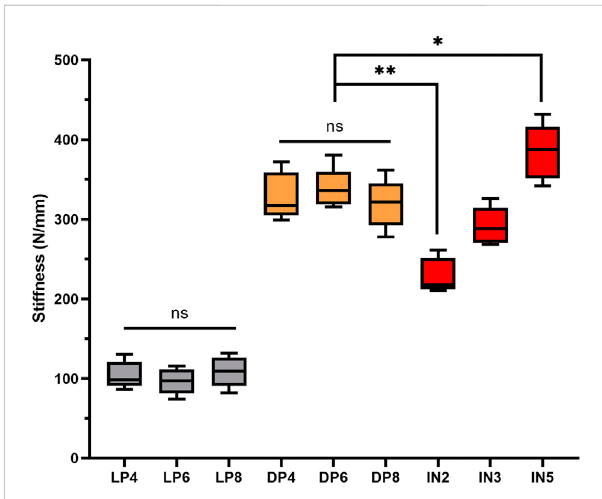
FIGURE 4 Axial static stiffness (median, range, n = 5) and signi fi cant differences among groups: lateral plate fi xation groups (LP), double plate fi xation groups (DP), intramedullary nailing groups (IN). (ns, no signi fi cant difference; * p < 0.05; ** p < 0.01).